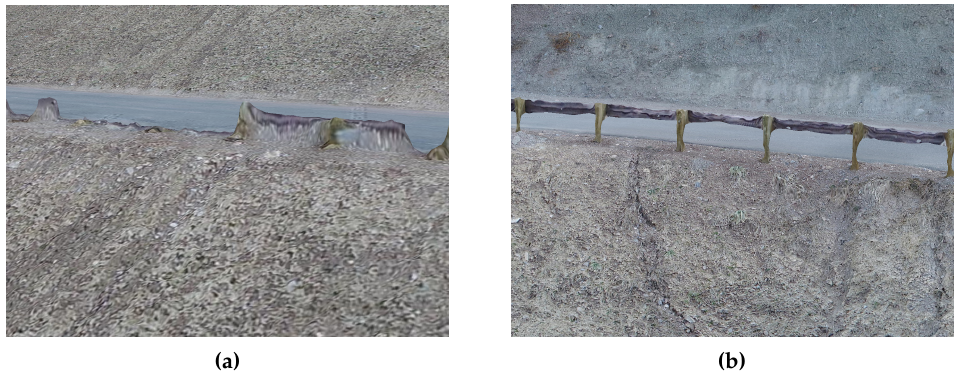
Figure 13. Visual comparison of guardrails in the ( a ) low and ( b ) high-priority regions. Guardrail spacing is 1.9